Question: Author a descriptive caption for the visualization shown.
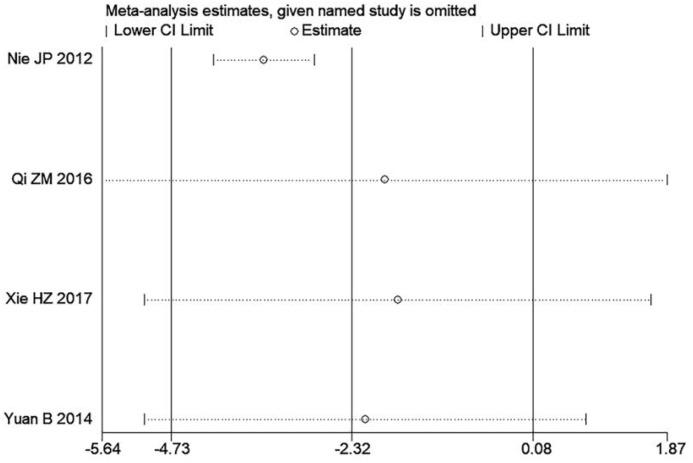
Answer: Results of the ESR sensitivity analysis in the CHM vs. WM group.